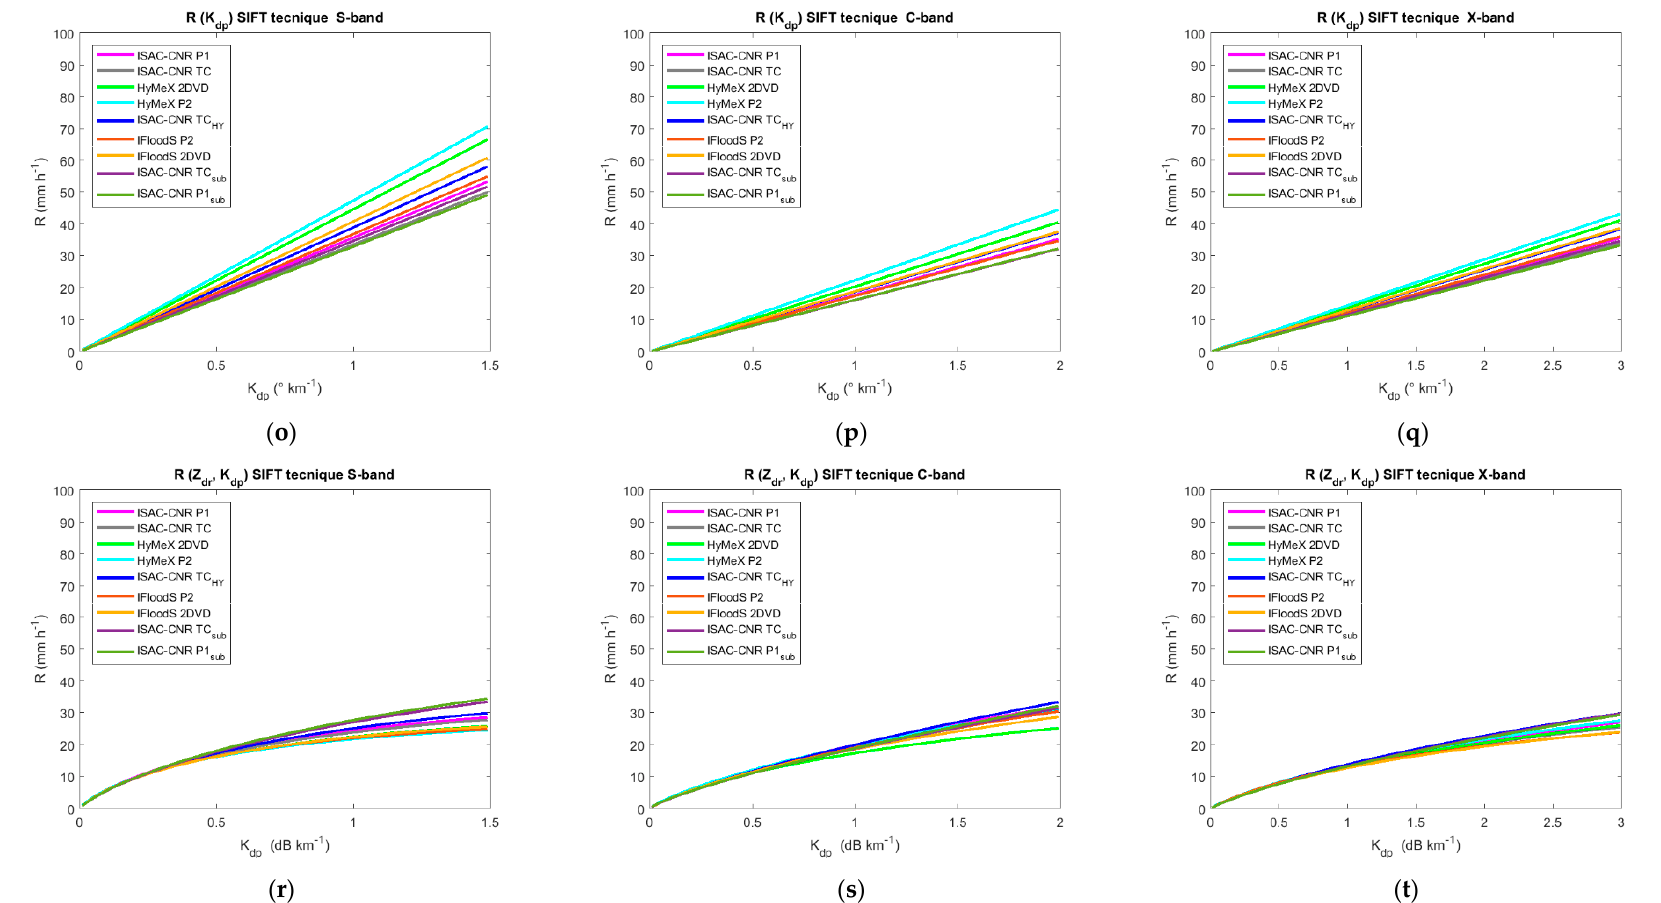
Figure 7. Representation of the weather radar algorithms obtained using different datasets of measured DSD and following the SIFT approach. ( a – c ) are a h ( K dp ) relations for S-, C-, and X-band, respectively; ( d – f ) are a d ( K dp ) relations for S-, C- and X-band, respectively; ( g – i ) are R ( Z h ) relations for S-, C-, and X-band, respectively; ( l – n ) are R ( Z h , Z dr ) relations for S-, C-, and X-band, respectively; ( o – q ) are R ( K dp ) relations for S-, C-, and X-band, respectively; and ( r – t ) are R ( Z dr , K dp ) relations for S-, C-, and X-band, respectively.